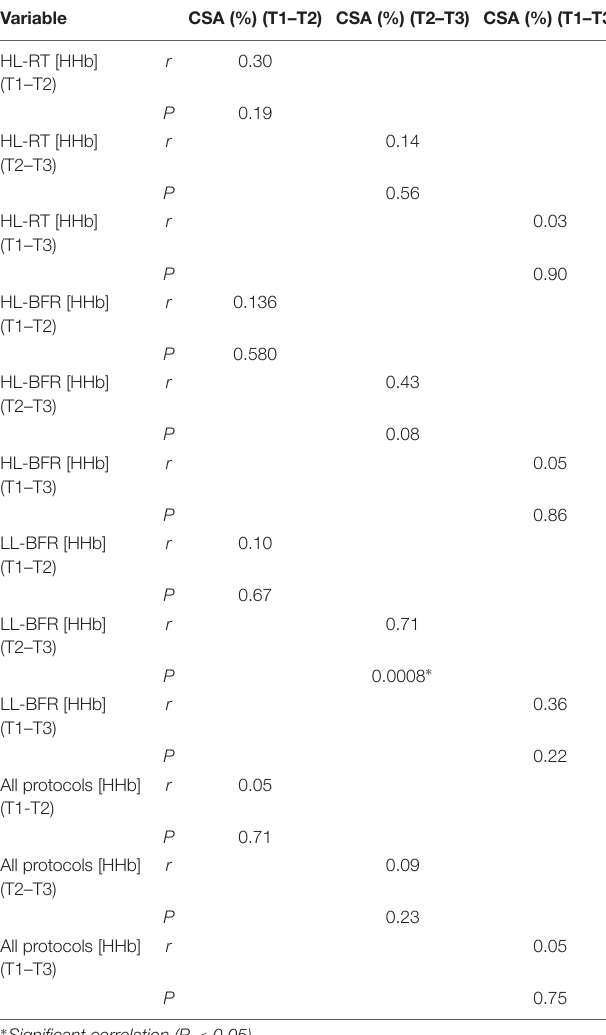
TABLE 2 | Correlations between changes in deoxyhemoglobin concentrations ([HHb]) and changes in muscle cross-sectional area (CSA) for high-load resistance training (HL-RT), high-load resistance training with blood flow restriction (HL-BFR), low-load blood flow restriction (LL-BFR) and all groups together.